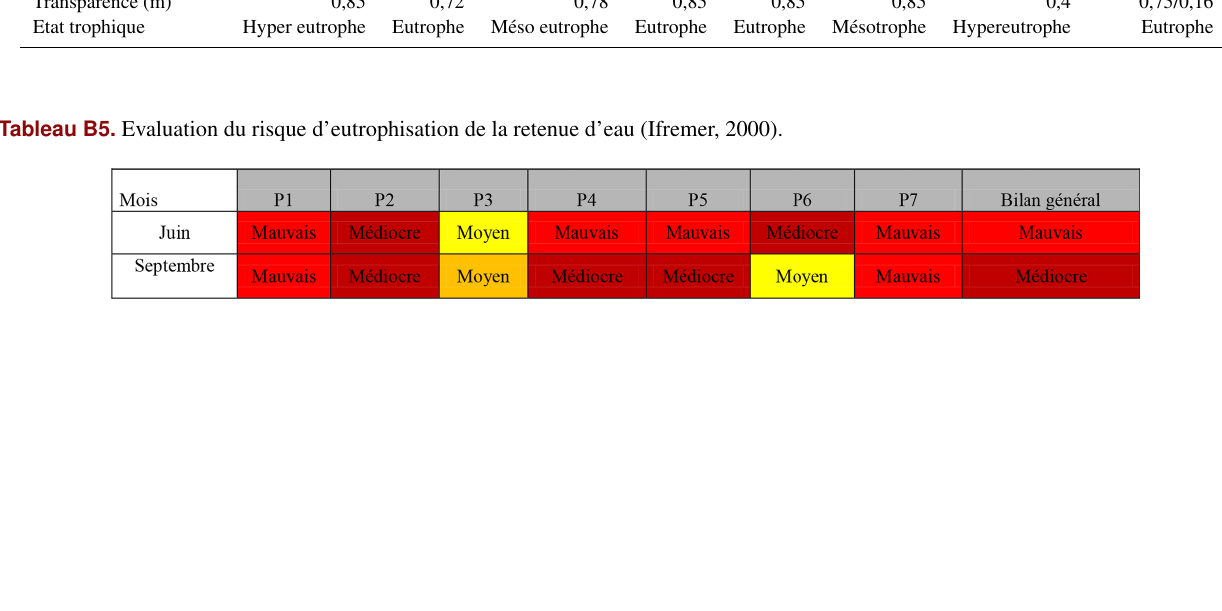
Proc. IAHS, 384, 99–105,